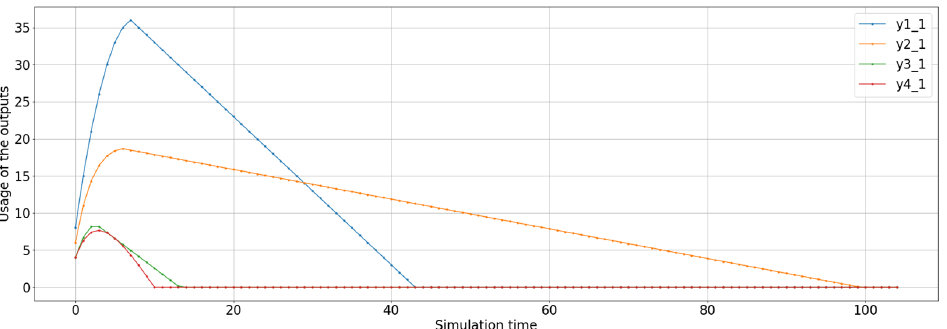
Figure 12. Solution for y-variables of the decentralised MPC.